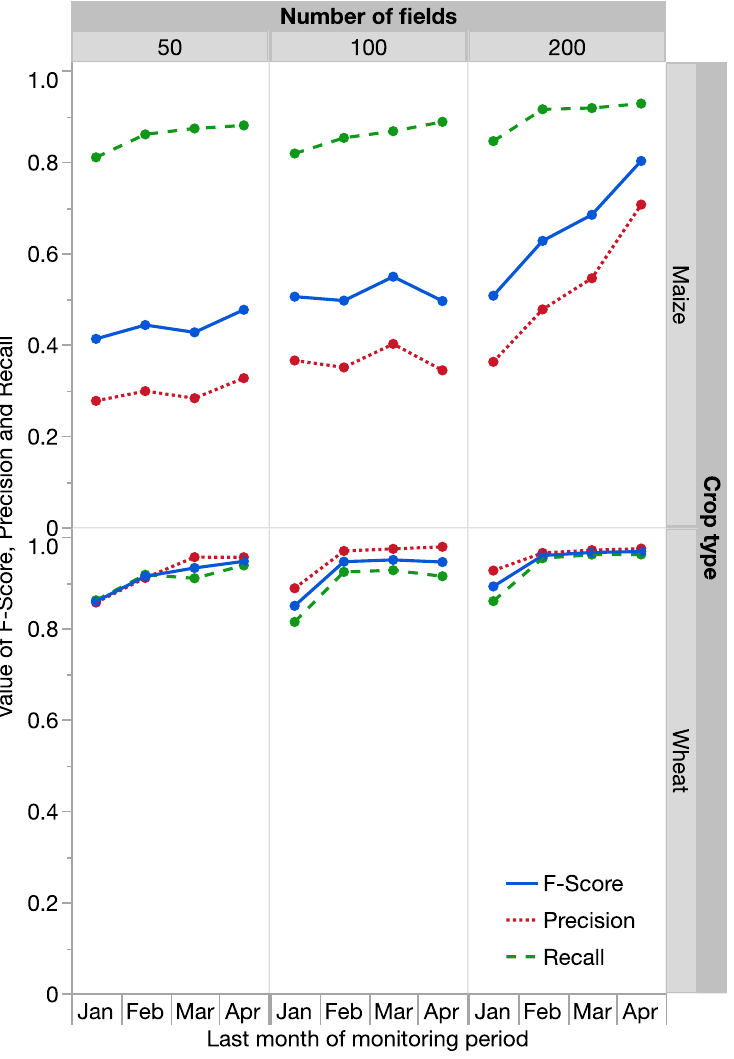
Figure 9. Classification accuracy in terms of F-Score, precision and recall resulting from a binary classification of either maize vs. all other crops or wheat vs. all other crops. The classifications were based on 50, 100 or 200 fields representing each class (maize vs. non-maize; wheat vs. non-wheat). Classifications spanned four different periods, ranging from November to January, February, March or April.